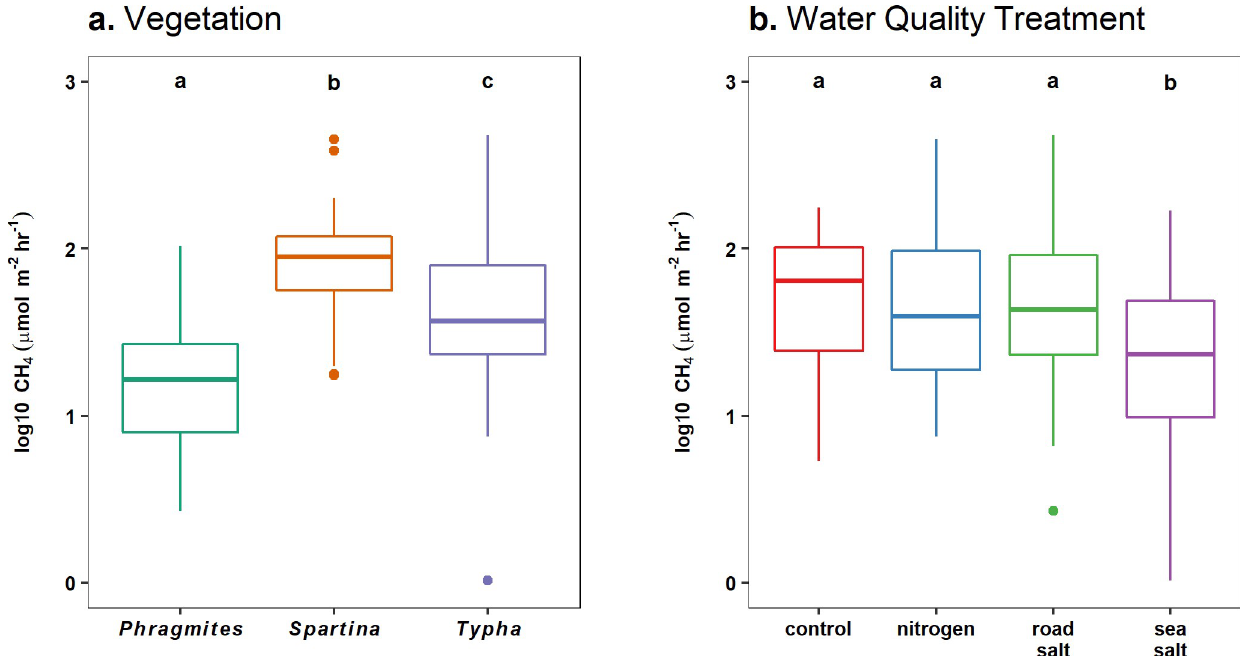
Fig 3. CH 4 emissions by vegetation and water quality treatments. 2017 CH 4 emissions from July, August, and September sampling campaigns were pooled and log transformed to examine differences among (a) vegetation and (b) water quality treatments. Differences between groups are indicated by non-overlap of letters, based on post-hoc Tukey